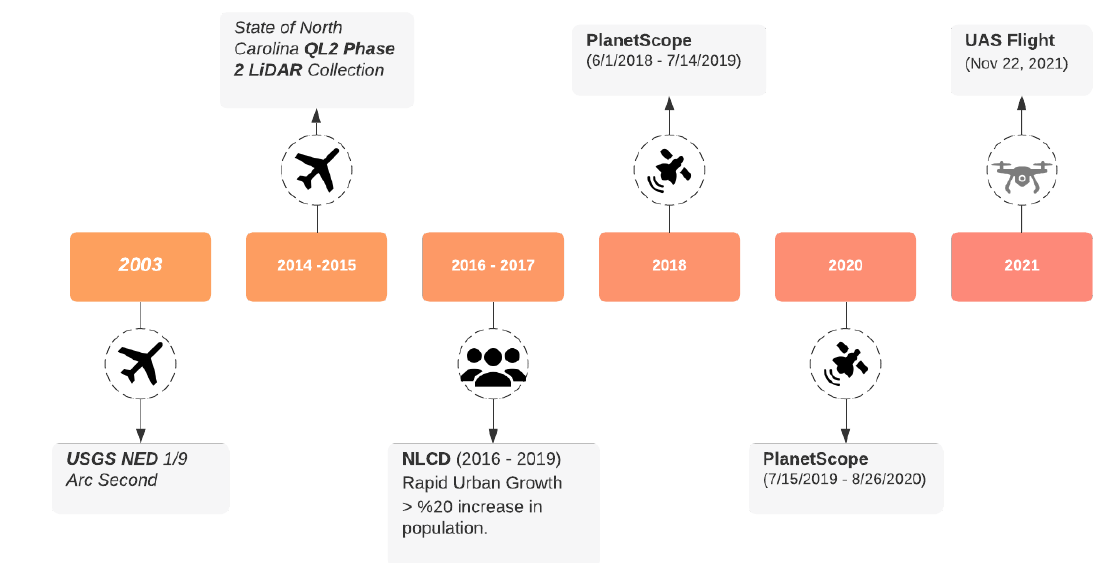
Figure 3. The datasets used for the case study were generated over a wide variety of spatial– temporal scales.